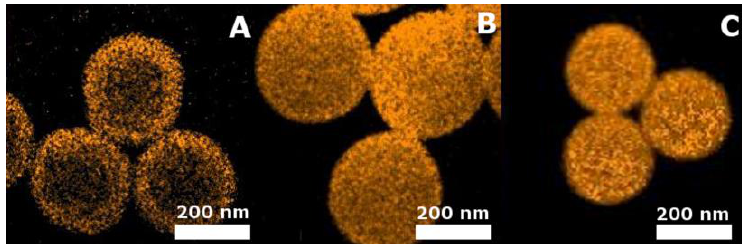
Figure 4. Scanning transmission electron microscopy – energy dispersive X-ray spectroscopy (STEM- EDS) mappings displaying the distribution of silicon in hybrid particles obtained at a ratio of MPTMS:styrene of ( A ) 20:80, ( B ) 50:50, and ( C ) 80:20.